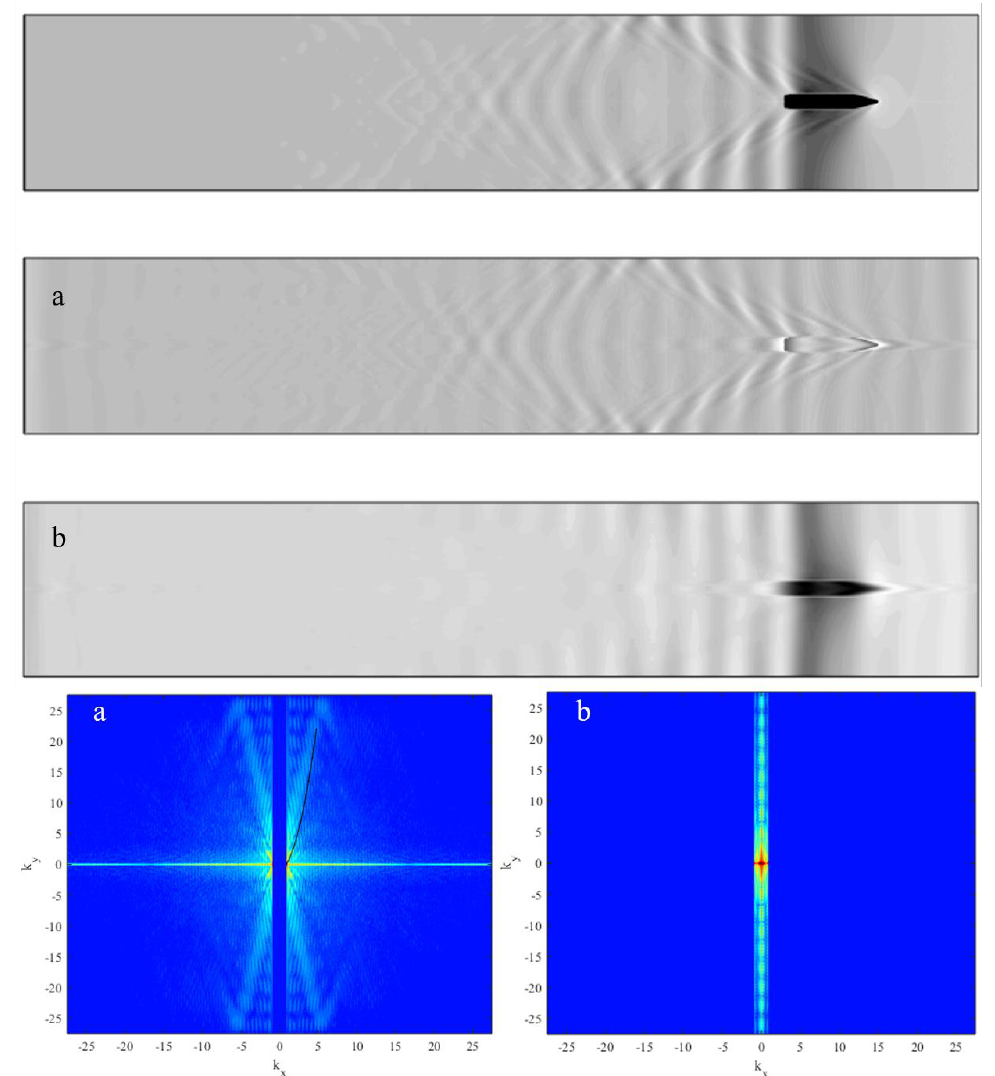
Figure 14. Splitting of near- and far-field components via manipulations of the spectrum (cut-off wave number 𝑘 𝑥𝑐 = 4.7885). Top: original free surface; ( a ) indicates the far-field component, whereas ( b ) indicates the near-field disturbance and their corresponding Fourier representations. Longitudinal extent: 32 m.